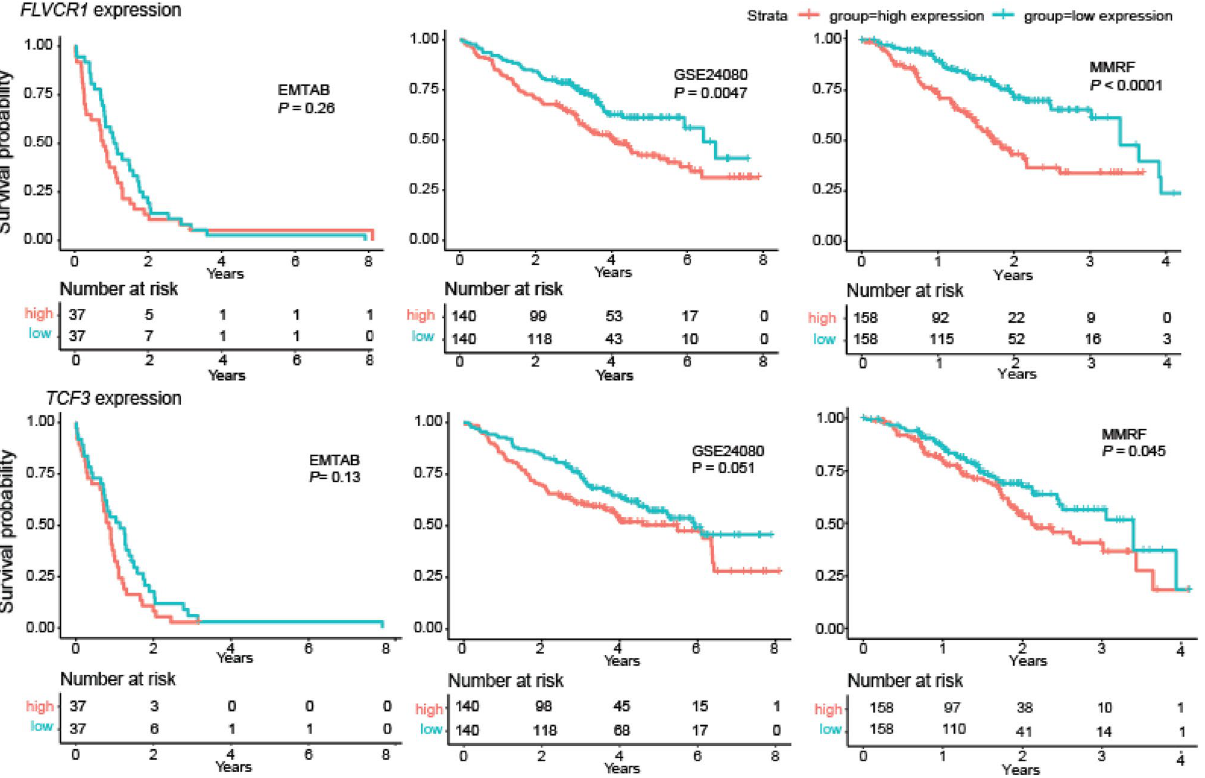
Figure 3. Kaplan–Meier curves for the relationship between expression of FLVCR1 and TCF3 and progression- free survival in three cohorts. The red line depicts the survival curve for higher (top 25%) expression of each gene, blue line depicts survival curve for lower (bottom 25%) expression of each gene. MMRF; MMRF CoMMpass IA10 RNA-seq. GSE20480 and E-MTAB-4032; microarray